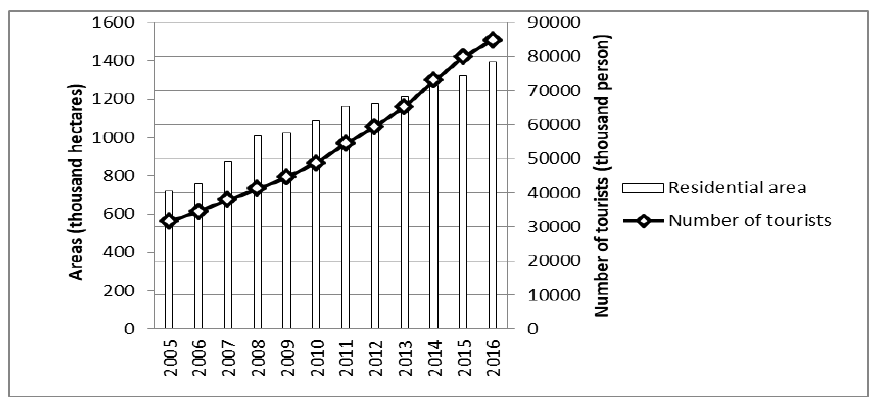
Figure 15. Dynamic of the number of tourists and residential area (vertical) in Vietnam [124].